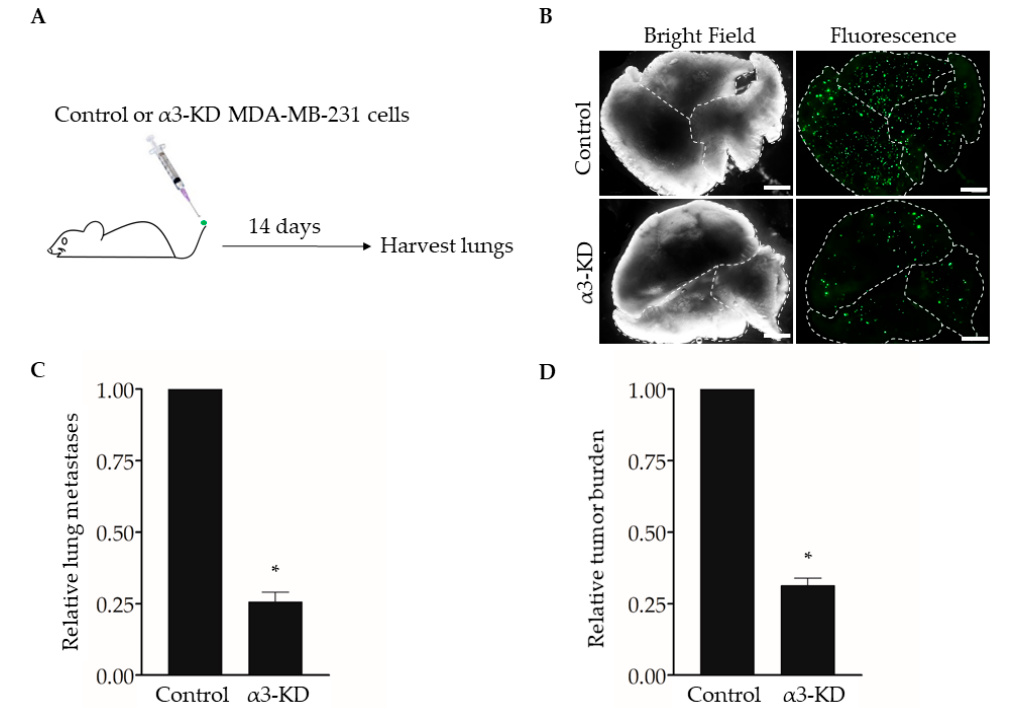
Figure 1. RNAi-targeting of the integrin α 3 subunit decreases lung colonization by MDA-MB-231 cells. ( A ) MDA-MB-231 cells that stably express either non-targeting shRNA (Control) or α 3-targeting shRNA ( α 3-KD) were labeled fluorescently by transduction with a lentivirus expressing ZsGreen (pHAGE- IRES- ZsGreen). A total of 5 × 10 4 cells were injected into the tail-vein of five-week-old, female NSG™ mice, and lungs were harvested 14 days later. ( B ) Representative bright field and fluorescent images of lungs from mice injected with either control or α 3-KD cells, as indicated. Dashed lines outline individual lobes. ( C , D ) Graphs showing ( C ) the relative number of lung metastases or ( D ) relative tumor burden, normalized to the average of the control. n = 6 (Control) or 7 ( α 3-KD); mean +/ − SEM; * p < 0.05; two-tailed T -test; scale bar, 2 mm. Similar results were obtained in a separate experiment using seven-month-old, female NSG™ mice ( n = 4 mice/group).